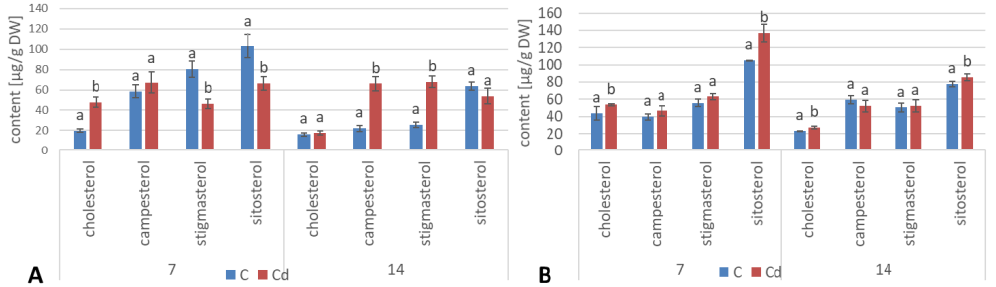
Figure 18. The content of sterol esters ( A ) and sterol glycosides ( B ) in C. officinalis roots. Bars which do not share a common letter are significantly different ( p < 0.05).